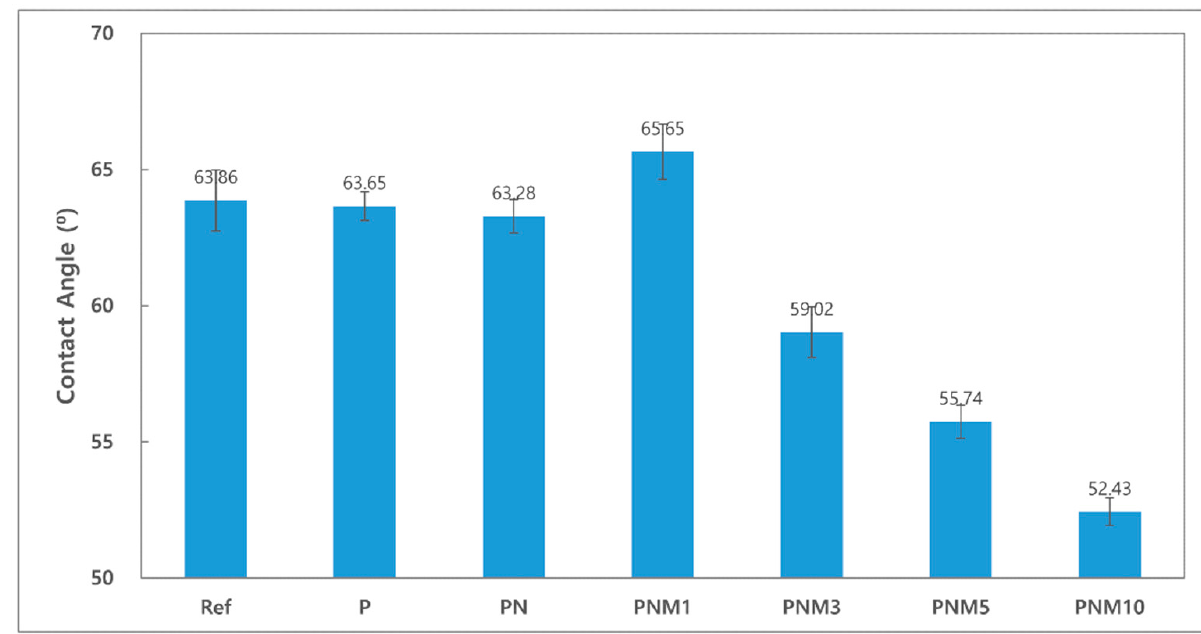
Figure 5. Contact angle of samples.